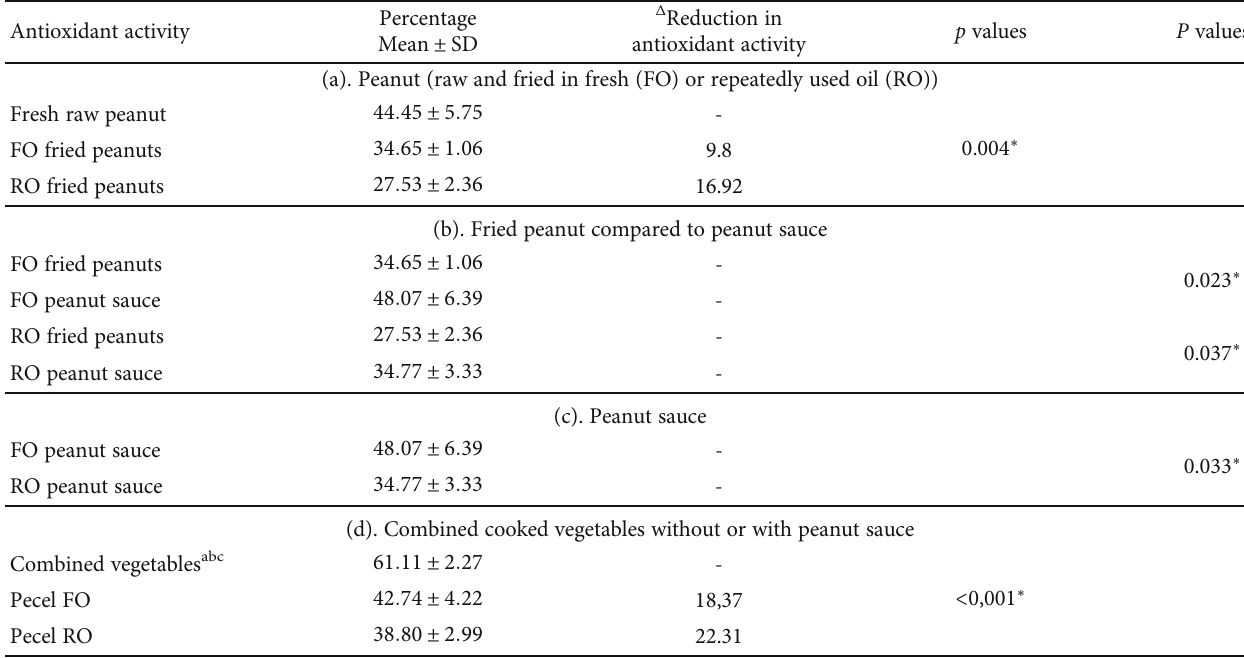
Table 3: Antioxidant activity of peanuts, peanut sauce, and combined cooked Pecel vegetables without or with peanut sauce. Antioxidant activity